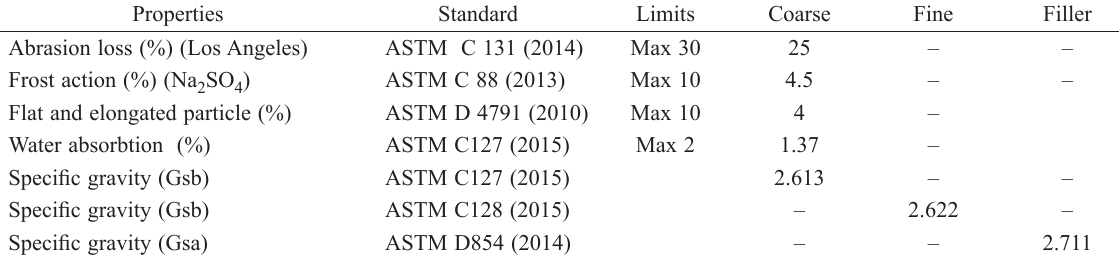
Table 3. Physical properties of